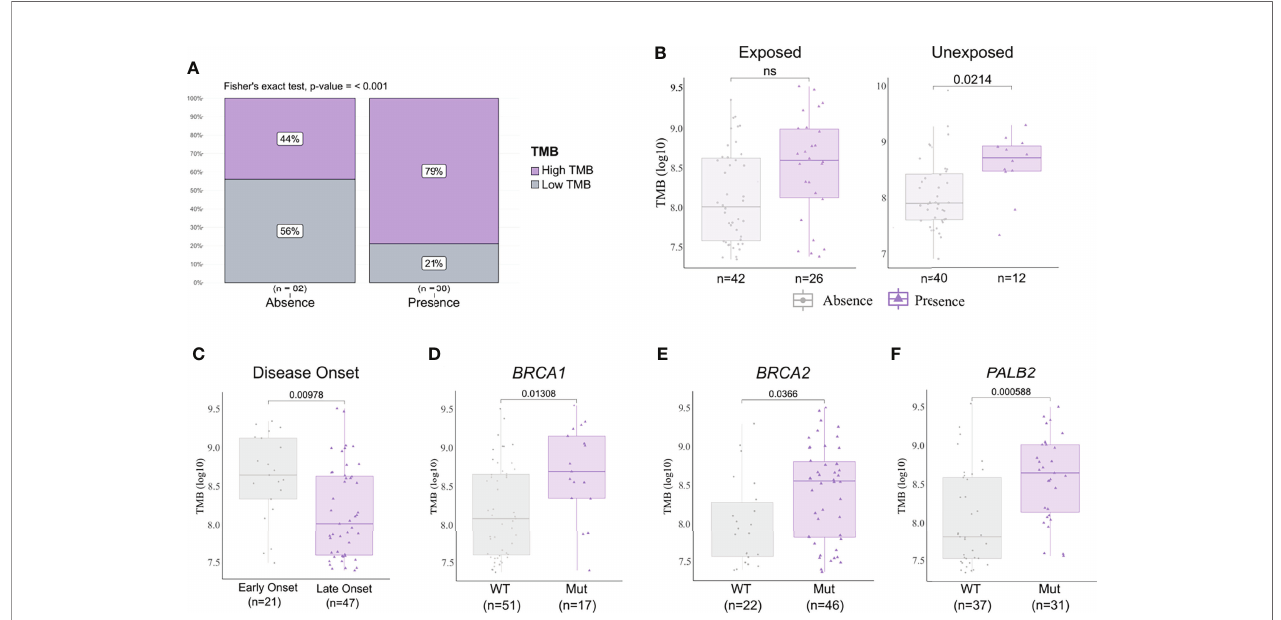
FIGURE 5 | Tumor mutational burden (TMB) and clinicopathological variables according to pesticide exposure. (A) Frequency of high and low mutational burden levels in tumor samples with a pathogenic and/or likely pathogenic variant detected or not. Tumors harboring any deleterious variant present increase in mutational burden (p < 0.001). (B) TMB levels in samples according to pesticide exposure status and grouped by presence or absence of any predicted pathogenic variant. Tumors from unexposed patients present increased TMB when harboring any deleterious variant (p = 0.0214); this result is not observed in tumors from exposed patients. (C) TMB levels in exposed patient samples grouped according to disease onset. We found early-onset tumors (patients with <50 years old) with signi fi cantly higher TMB (p = 0.00978) in comparison to late-onset tumors (patients with ≥ 50 years old). (D – F) TMB levels in exposed patient samples grouped according to BRCA1 , BRCA2 , and PALB2 statuses, respectively. Tumors harboring a mutation in BRCA1 (p = 0.01308), BRCA2 (p = 0.0366), and/or PALB2 (p = 0.000588) presented higher TMB than wild-type tumors. The expanded form of “ NS ” means “ No signi fi cance ”